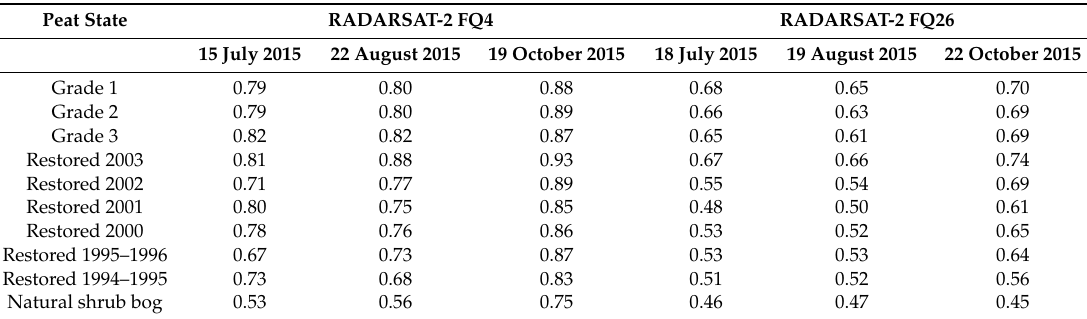
Table A1. Degree of